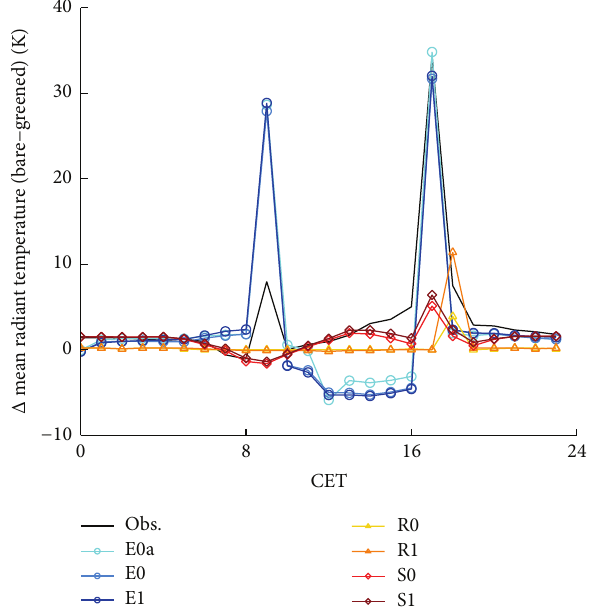
Figure 9: Differences between the bare and greened site in obser- vation and simulations (7, 23, 2013) in experiments with ENVI- met 3 (E0a), unforced (E0) and forced ENVI-met 4 (E1), RayMan without (R0) and with global radiation from observation (R1), and SOLWEIG without (S0) and with global radiation from observation (S1).